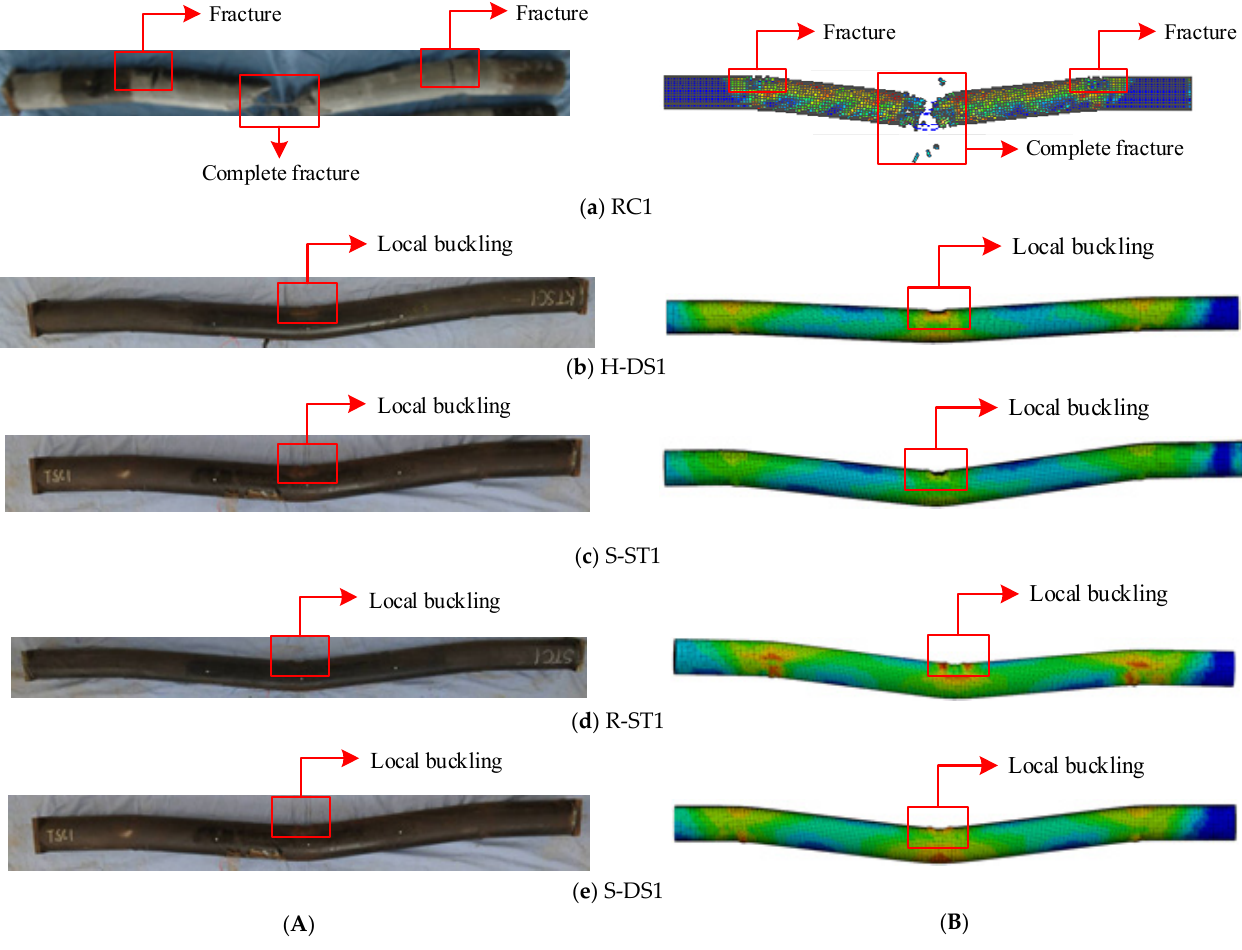
Figure 4. Comparison of observation and prediction of typical failure modes of RC columns and composite columns. ( A ) Observed in the test and ( B ) Predicted in FEA